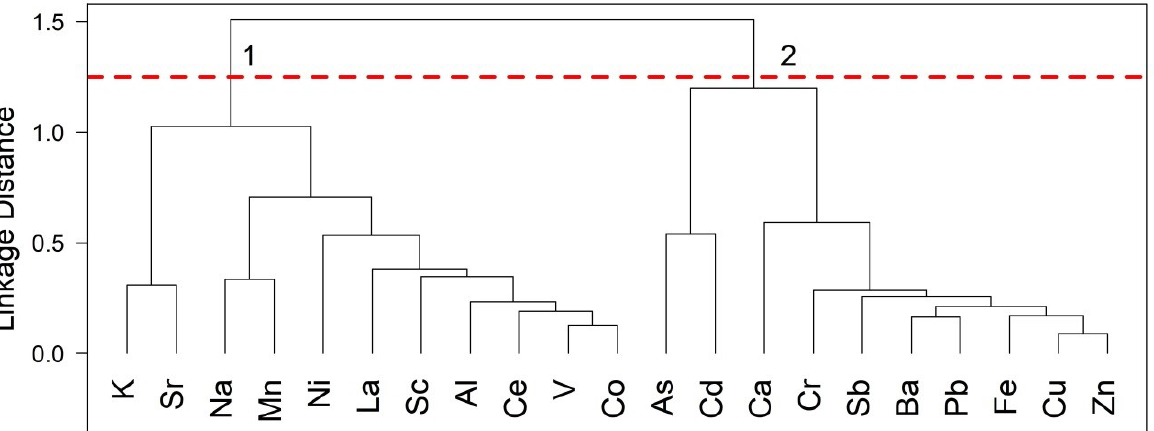
Figure 8. Results of the hierarchical cluster analysis (dendrogram) of the elements measured in